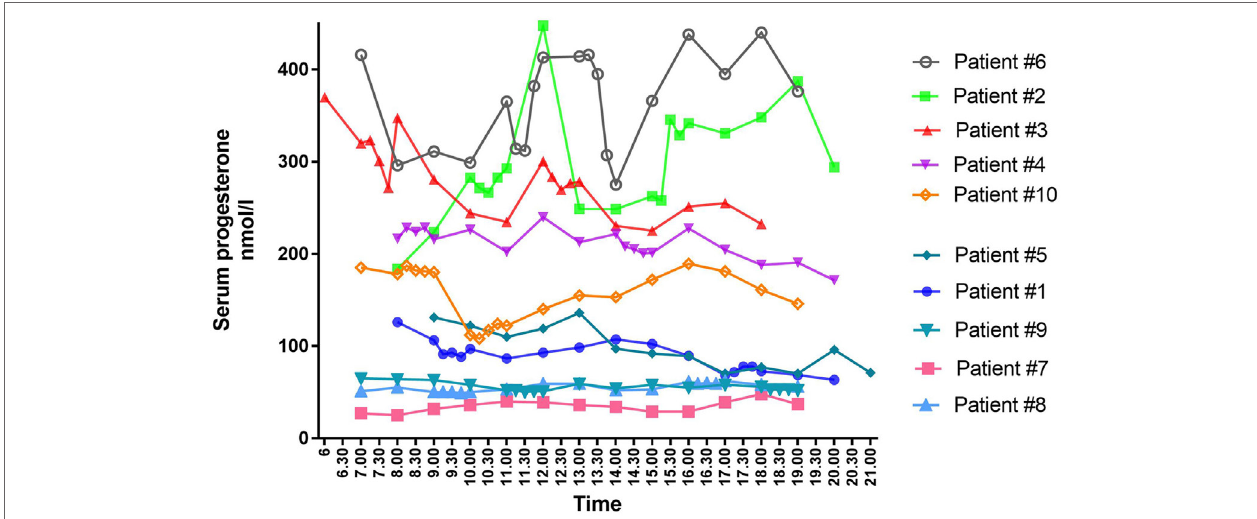
FigUre 1 | Individual mid-luteal serum profiles of progesterone over a 12-h interval in 10 patients undergoing controlled ovarian stimulation for in vitro fertilization